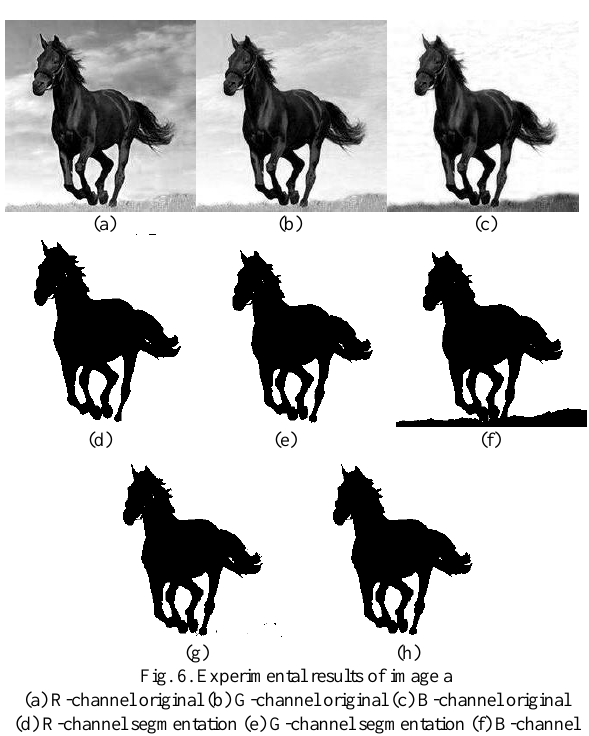
Fig. 6. Experimental results of image a